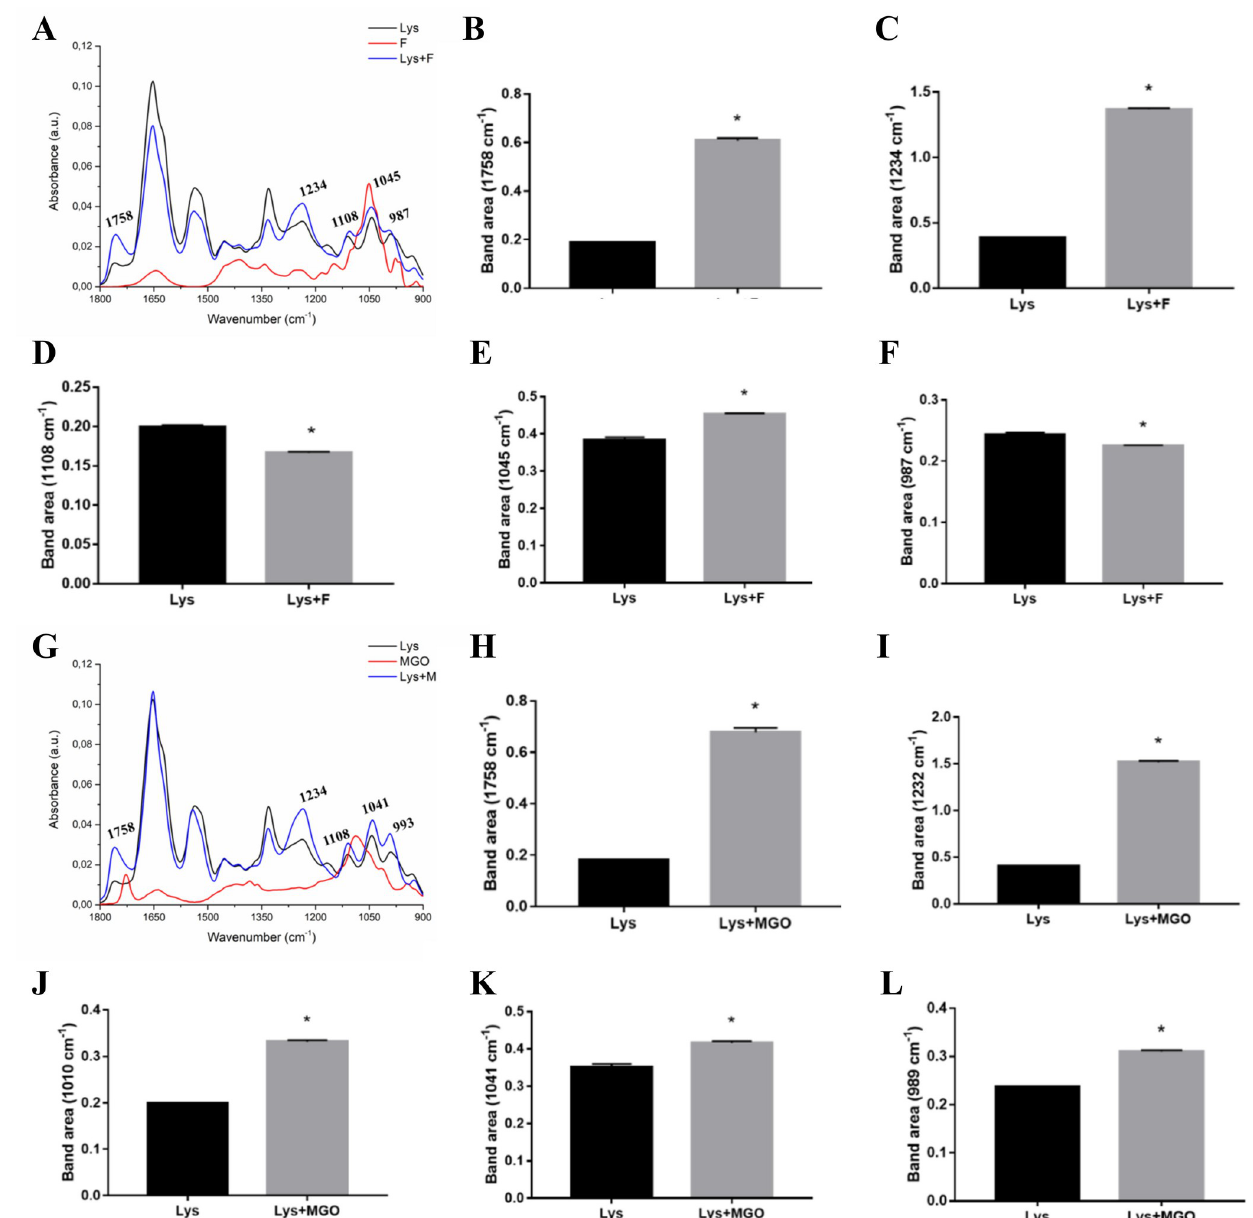
Fig 3. Average ATR-FTIR spectra (1800–900 cm -1 ) of LYS, fructose, MGO, and LYS incubated with these glycating agents. (A) LYS and LYS with fructose (LYS+F). Peak area of the spectra in vibrational modes in 1758 cm -1 (B), 1234 cm -1 (C), 1108 cm -1 (D), 1045 cm -1 (E) and 987 cm -1 (F). (G) Average spectra of LYS and LYS with MGO (LYS+MGO). Peak area of the spectra in vibrational modes in 1758 cm -1 (H), 1234 cm -1 (I), 1108 cm -1 (J), 1041 cm -1 (K) and 993 cm -1